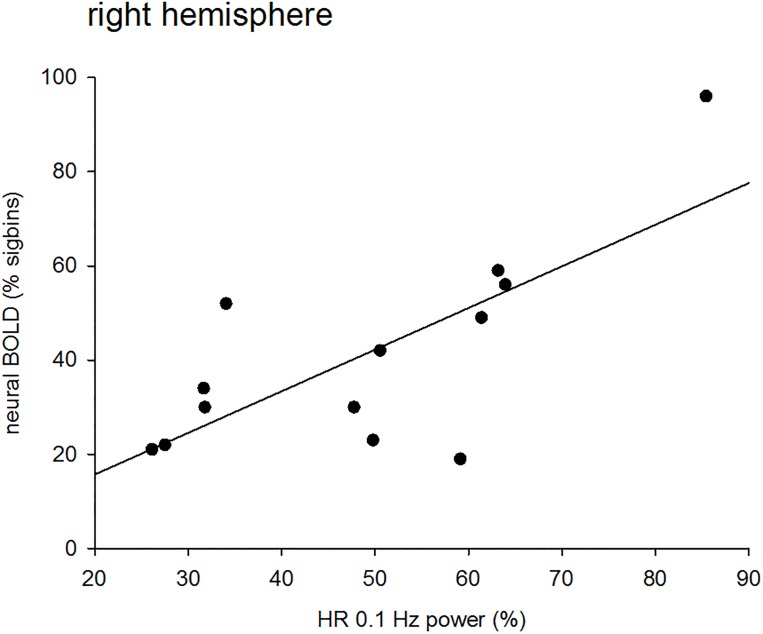
Significant positive correlation (p<0.01) between neural BOLD (%sigbins) and HRV (0.1-Hz power) in the right hemisphere of subjects with pTD in R1.